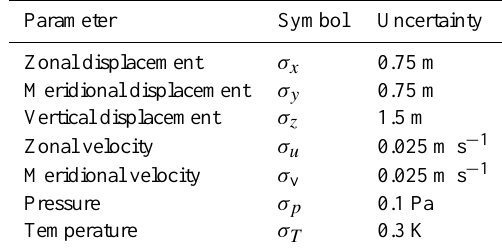
Table 3. SPB measurement